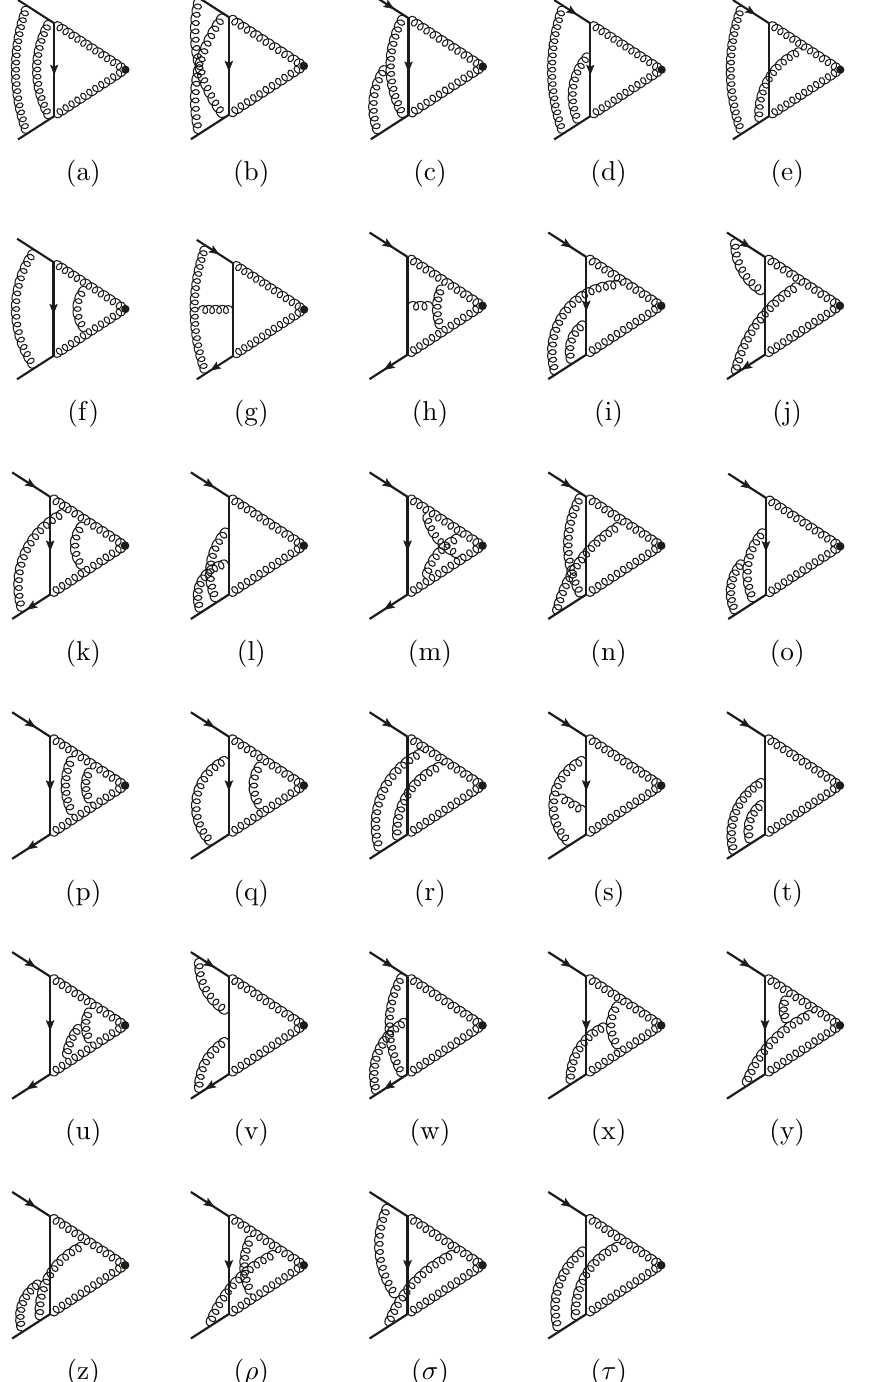
Figure 4 . The three-loop Feynman diagrams for the quark scattering by the ( G a contribute in the double-logarithmic approximation. Symmetric diagrams are not shown.